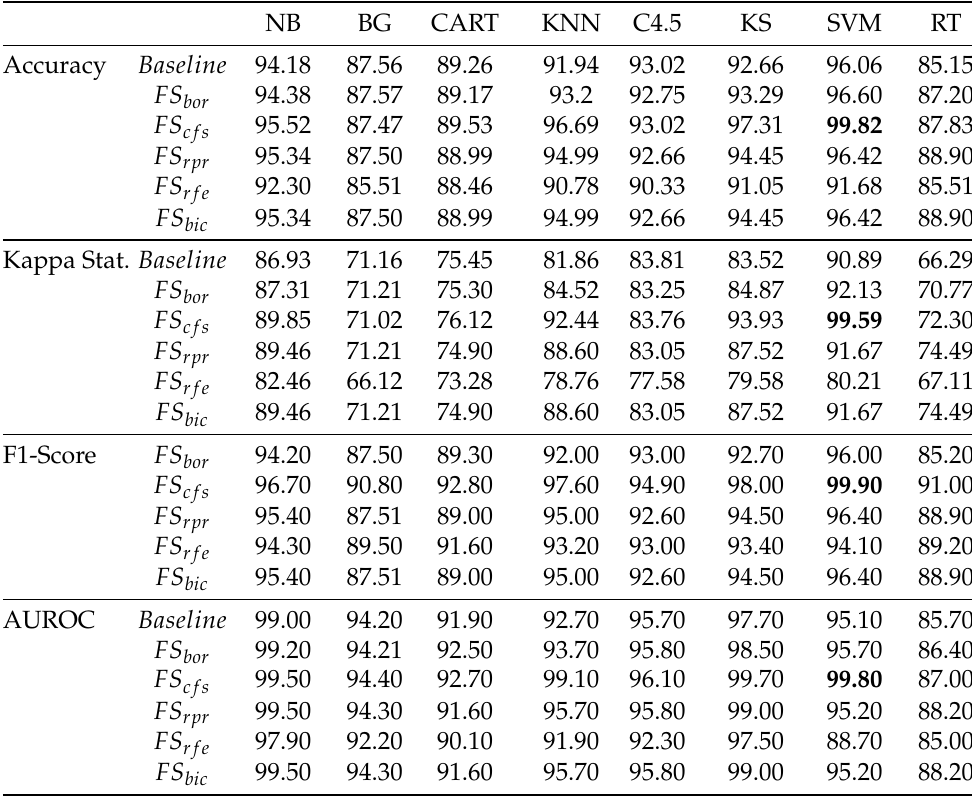
Table 8. Performance analysis of classifiers for baseline and its generated feature subsets of